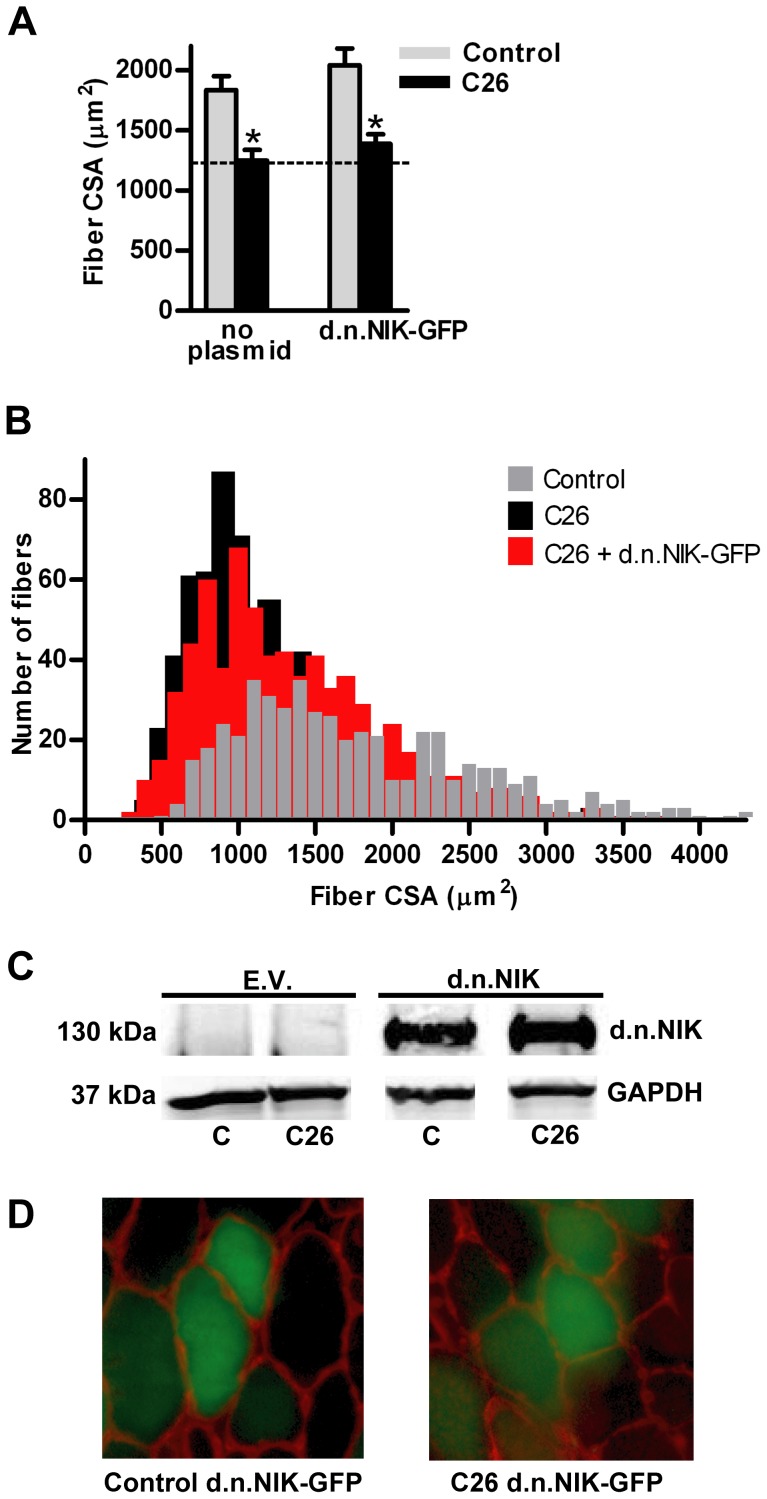
Effects of d.n. NIK on muscle fiber cross sectional area (CSA).(A) Mean tibialis anterior (TA) fiber cross-sectional area in control and C26 tumor-bearing mice in the presence or absence of d.n. NIK. Each bar represents mean fiber area from 8 muscles (± SE). (B) Fiber area frequency distribution of all fibers from muscles of control, C26, and C26 + d.n. NIK groups. (C) Western blots of lysates from TA muscles injected with the empty vector (EV) or d.n. NIK plasmid confirms overexpression of the protein. d.n. NIK = 130 kDa. All samples are from the same immunoblot. (D) Representative cross sections of TA muscles from control and C26 tumor-bearing mice injected with the d.n. NIK plasmid (encodes GFP on separate cistron). C  =  control. * significantly different from control (P<0.05).